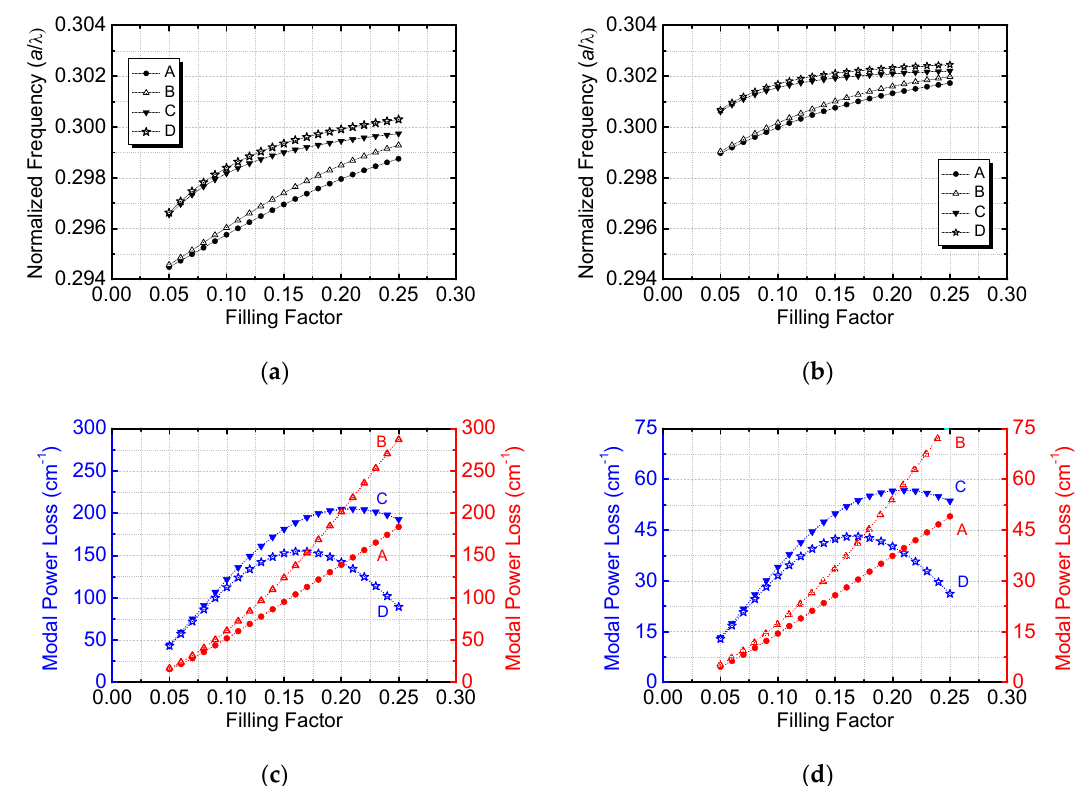
Figure 6. Infinite cavity with CC design ( f 1 = 3 f 2 , ∆ = a /3): the normalized frequencies of four band-edge modes versus filling factor for ( a ) air-hole and ( b ) air-pillar PC-SELs; the modal power losses of four band-edge modes versus filling factor for ( c ) air-hole and ( d ) air-pillar PC-SELs.